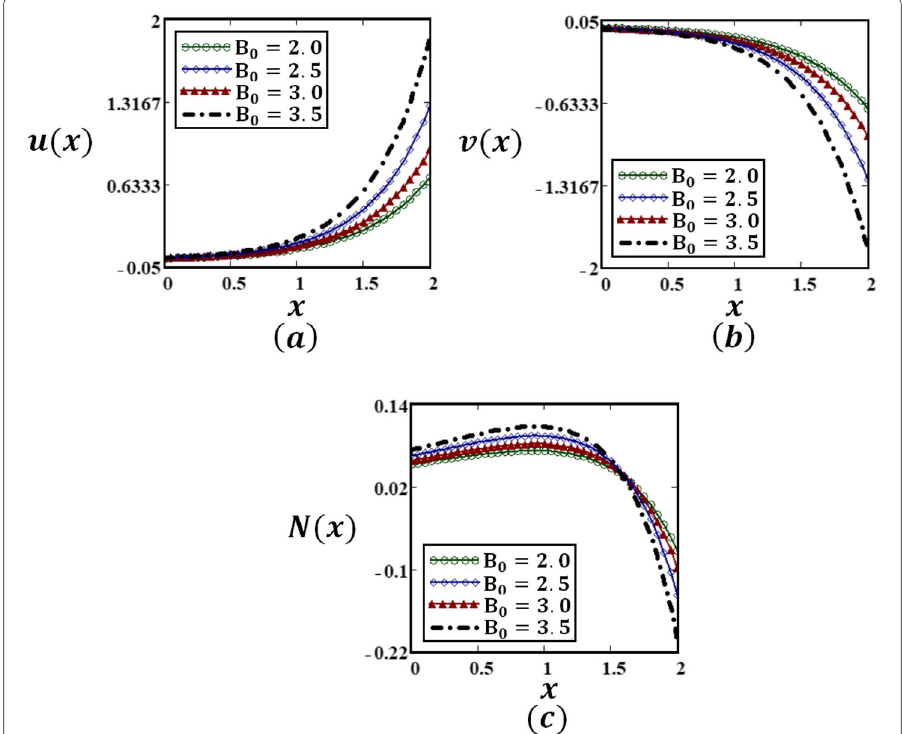
Fig. 7 Profiles of the velocity field u ( x , t ) , v ( x , t ) , and microrotation N ( x , t ) for MHD micropolar fluid given by Eqs. (32), (33), and (34), for U = 0.1, ν = 0.045, μ = 0.5, κ = 0.2, k ∗ = 0.2, σ = 0.2, j = 0.03, m = n = 1, y = 1, c 0 = 0.01, t = 2 s , and different values of B